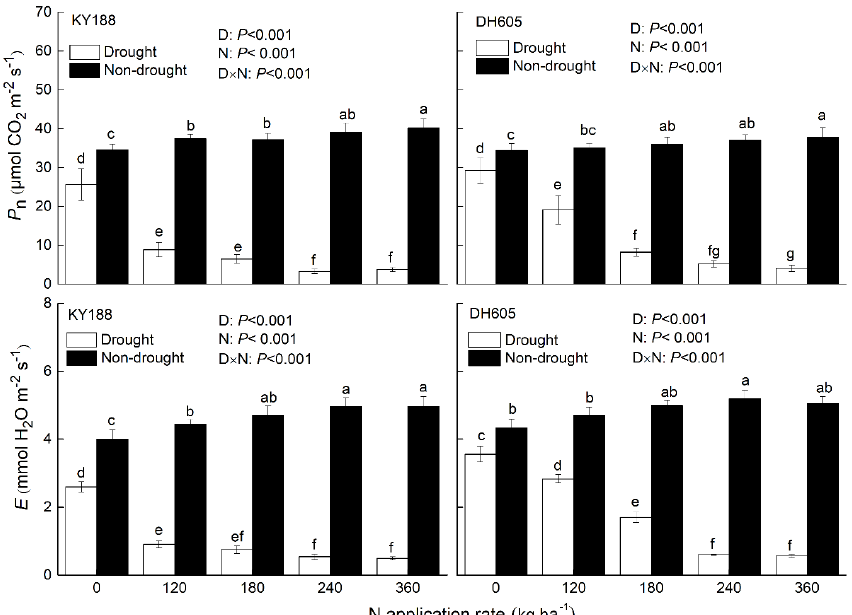
Figure 5. Net photosynthetic rates ( P n ) and transpiration rates ( E ) of maize grown subjected to drought and nondrought stress under different N levels. Significant differences between two water conditions at the same N level are indicated by ns (no significance), * ( p < 0.05), and **( p < 0.01). Different letters in the same column denote significant differences between different treatments for the same cultivar ( p < 0.05). Each bar represents the mean ± SD (n = 3).